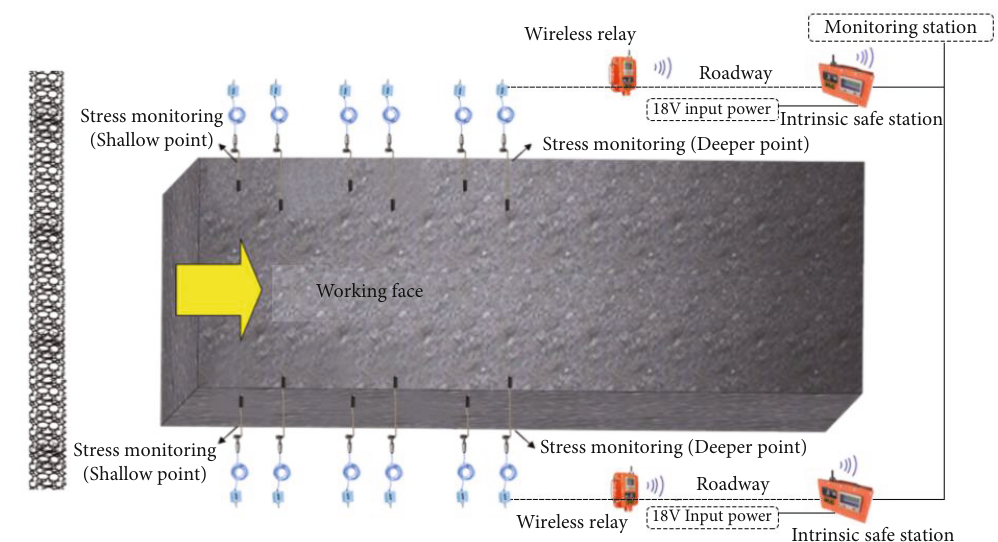
Figure 11: 42108 hardware composition and layout of monitoring equipment for top and bottom displacement of auxiliary transportation.